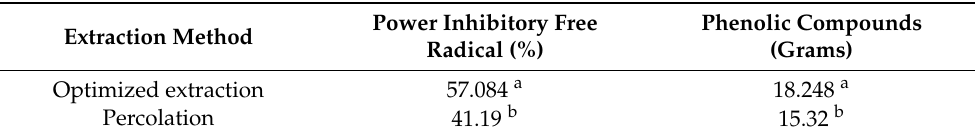
Table 3. Ultrasound-assisted extraction (UAE) (optimized extraction method) compared with the percolation method (conventional solvent